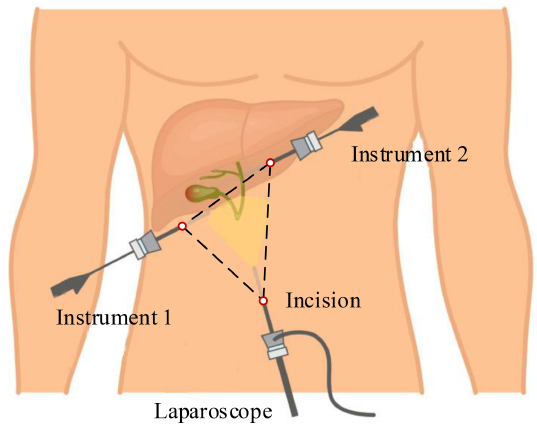
Figure 1. The schematic diagram of surgical incisions.